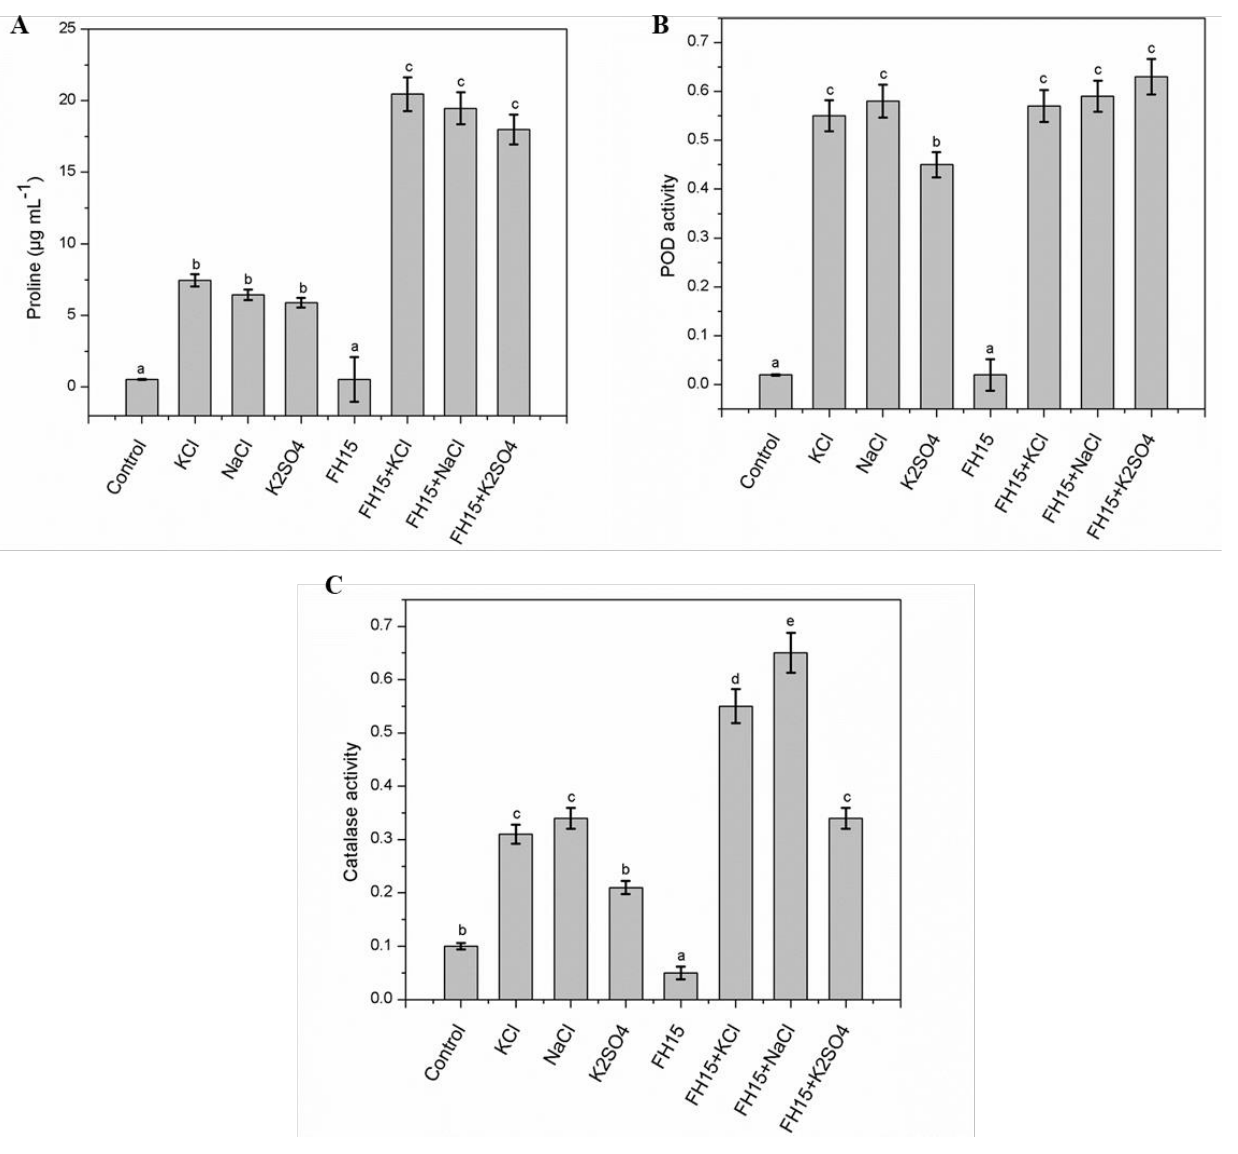
Figure 5. Effect of different salts on endogenous ( A ) proline content ( B ) peroxidase and ( C ) Catalase activity of maize with or without endophytic fungal strain C. membranifaciens FH15. The bars represent mean with ± SE and the different letters on the bars represent significance at p = 0.05.